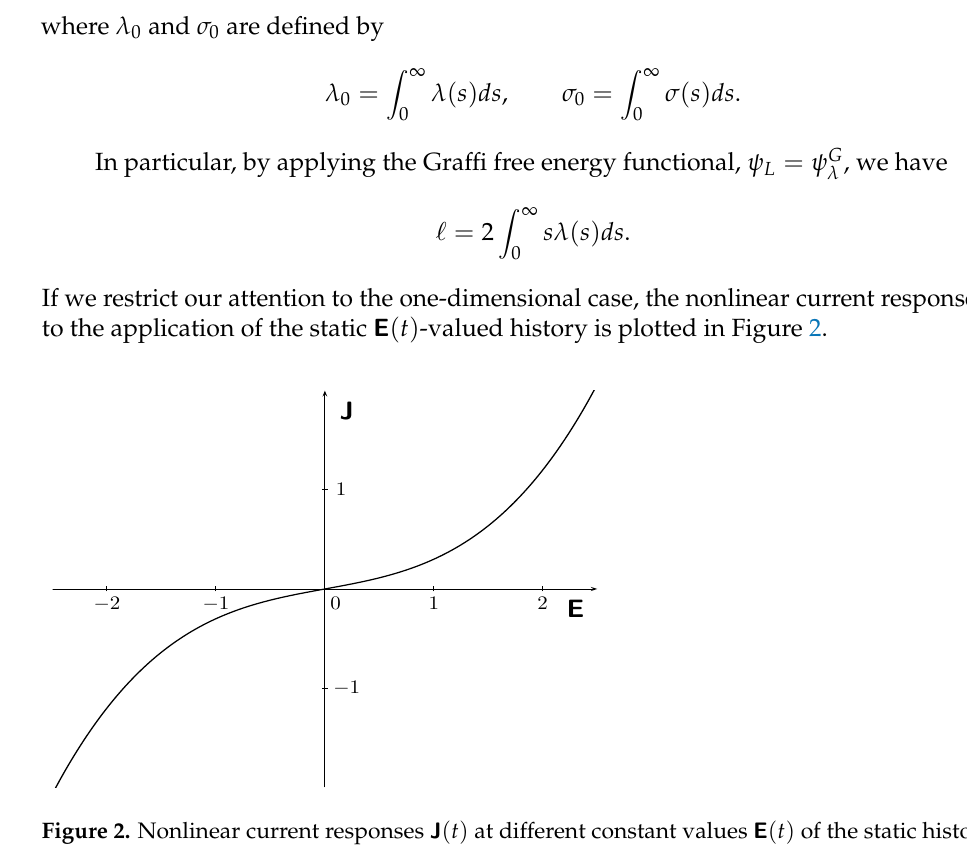
Figure 2. Nonlinear current responses J ( t ) at different constant values E ( t ) of the static history E † with σ 0 = 0.2 and λ 0 (cid:96) =